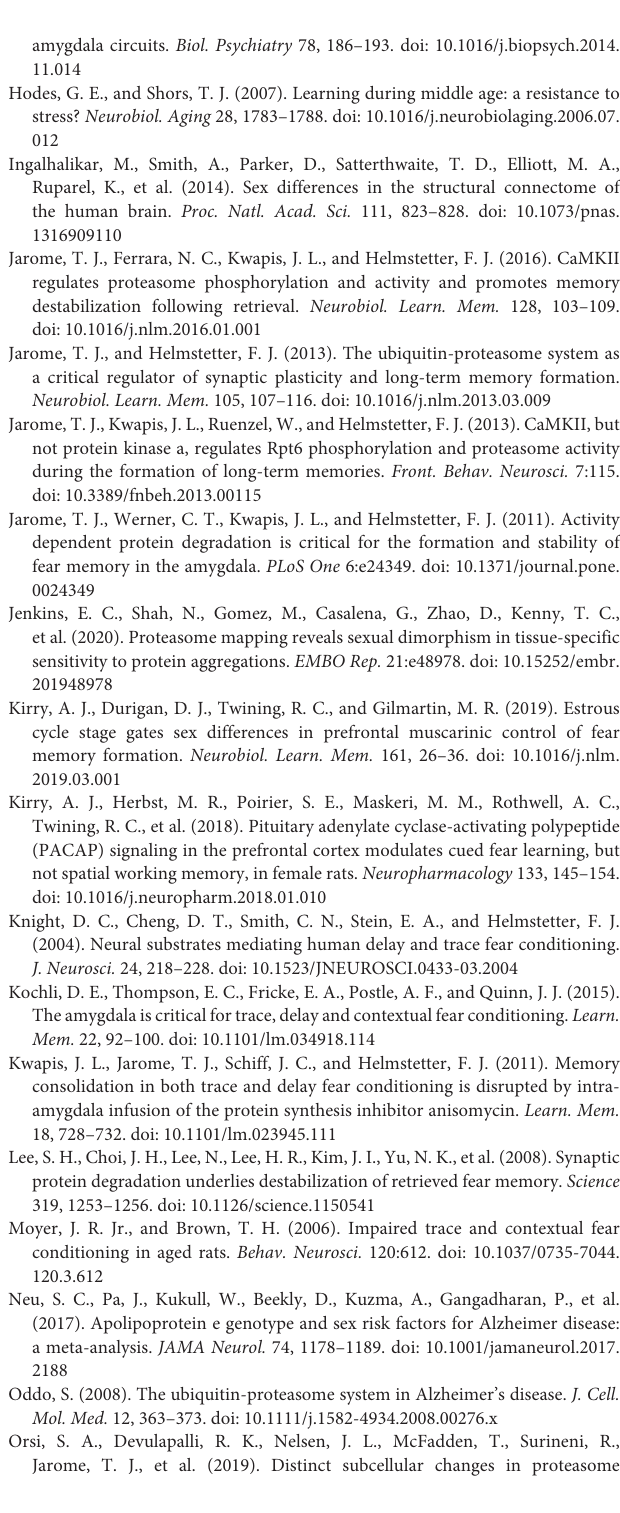
SUPPLEMENTARY FIGURE 2 | Synaptic fractions were also obtained from the DH, and western blots were used to analyze pRpt6, tRpt6, β -actin, and K48-linked polyubiquitination. In males, no differences were observed in pRpt6 (A) , tRpt6 (B) , β -actin (C) , or K48 (D) . Similarly, in females, no differences were observed in pRpt6 (E) , tRpt6 (F) , β -actin (G) , or K48 (H) . Results are presented as mean ±